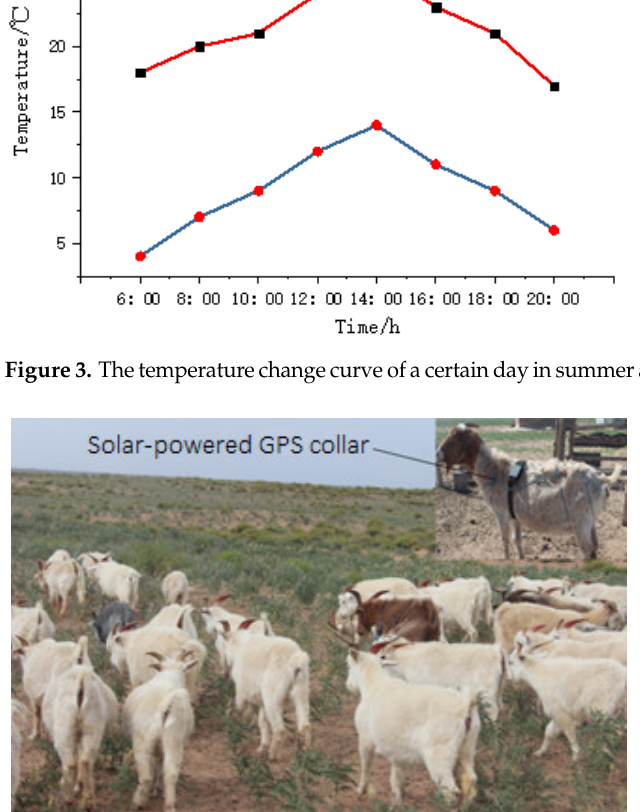
Figure 3. The temperature change curve of a certain day in summer and autumn in the experi- mental area.